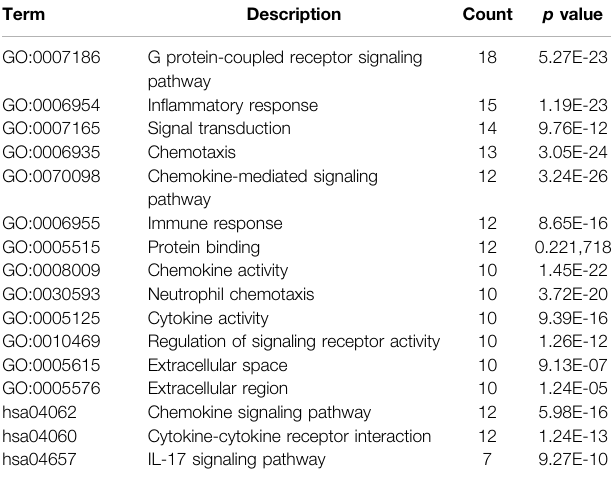
TABLE 2 | Function and pathway enrichment analysis of genes in cluster